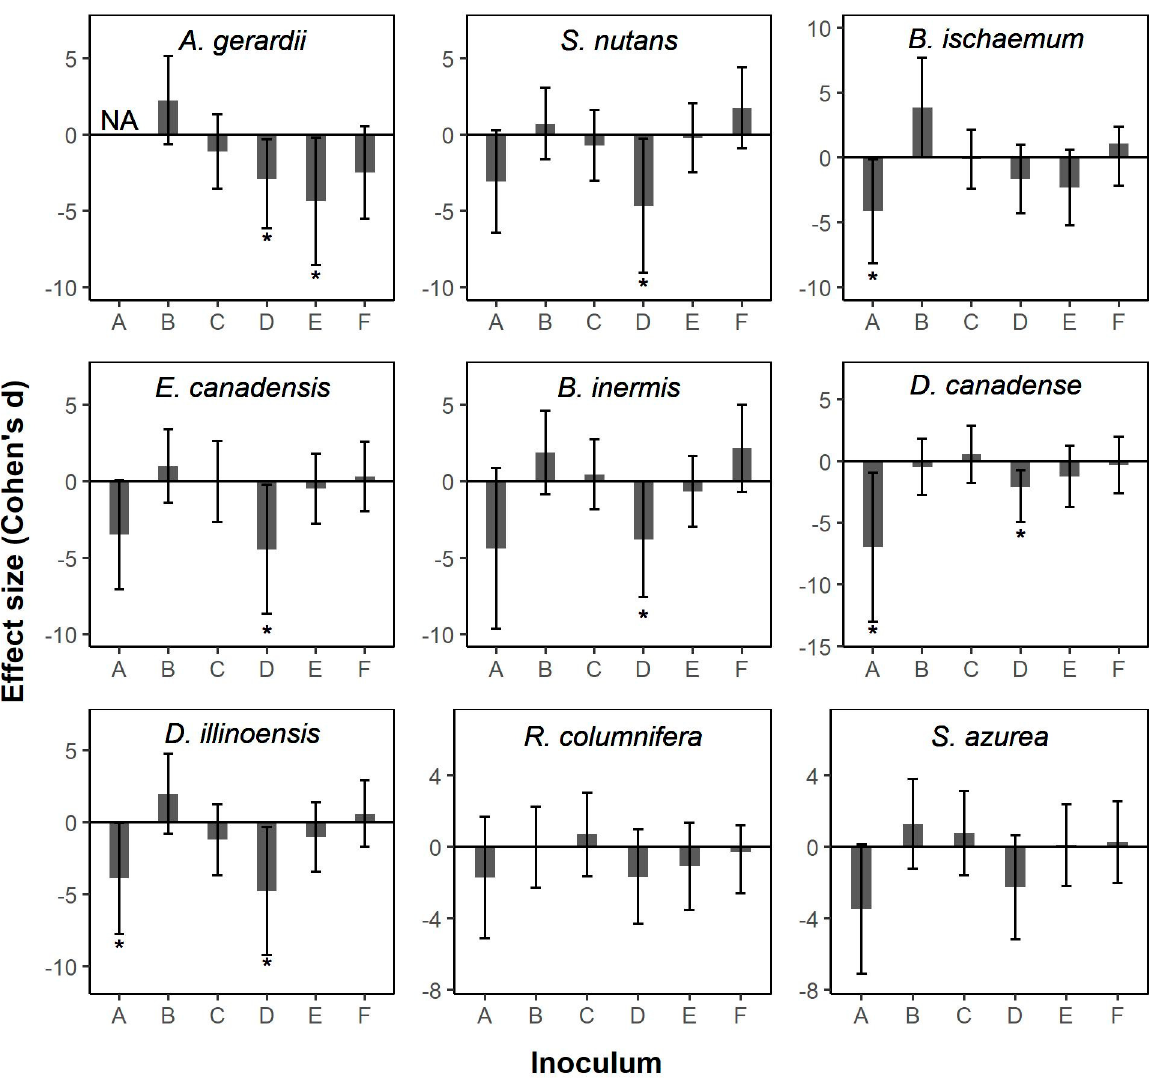
Figure 2. Effect sizes (Cohen’s d) of commercial arbuscular mycorrhizal (AM) fungal inoculants on the intra-radical colonization of nine plant species commonly found in central North American grasslands ( Andropogon gerardii ; Sorghastrum nutans ; Bothriochloa ischaemum ; Elymus canadensis ; Bromus inermis (invasive); Desmodium canadense ; Desmanthus illinoensis ; Ratibida columnifera ; Salvia azurea ). Descriptions of inoculums A–F are given in Table 2. Error bars represent 95% confidence intervals. Asterisks indicate significant effect sizes, as determined when confidence intervals did not overlap zero. Note: Due to high mortality of A. gerardii with product A, too few root samples were collected to assess AM fungal colonization; represented here as NA.